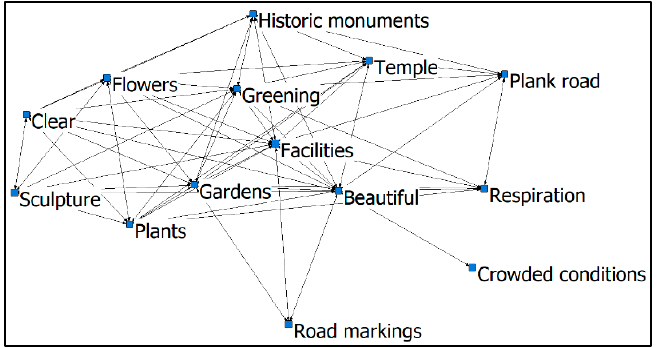
Figure 8. 1-2. Humanistic landscape based on visual and olfactory interactive perception.